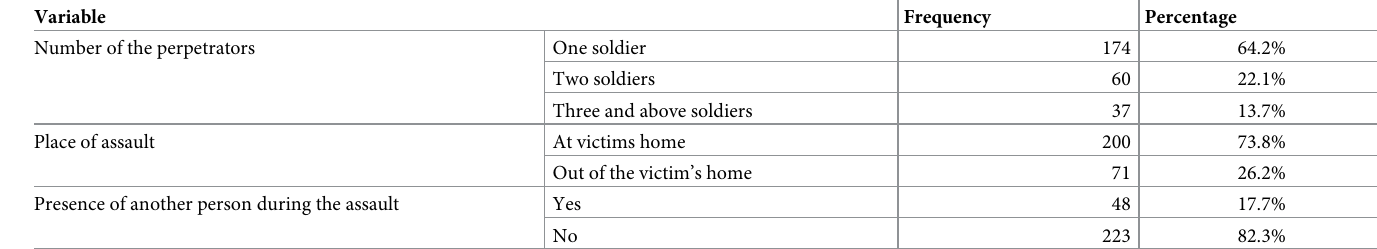
Table 2. Features of sexual assault during armed conflicts in Northeast Ethiopia, 2022 (n =